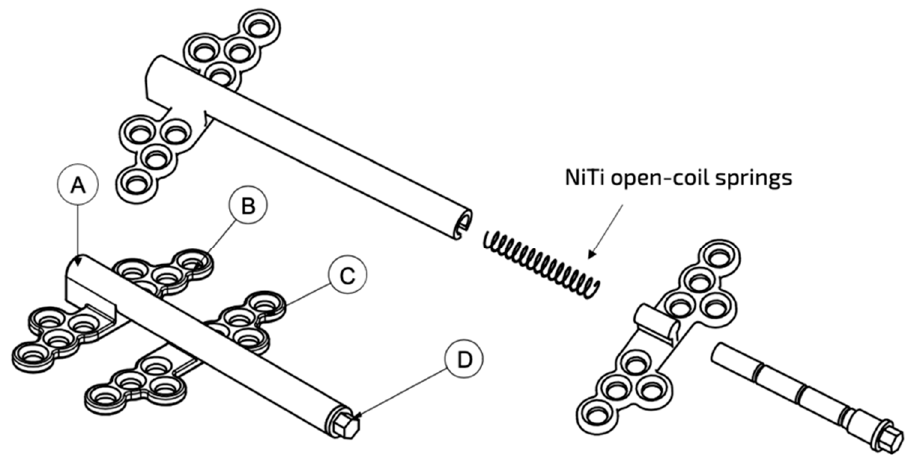
Figure 2. A drawing design showed the function of a new prototype of an alveolar distractor: (A) distraction tube; (B) fixed base plate; (C) moveable base plate; (D) holding rod.